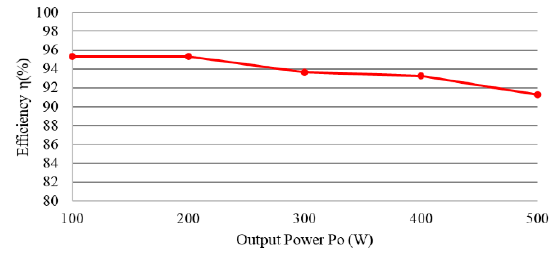
Figure 23. Efficiency curve in step-up mode.